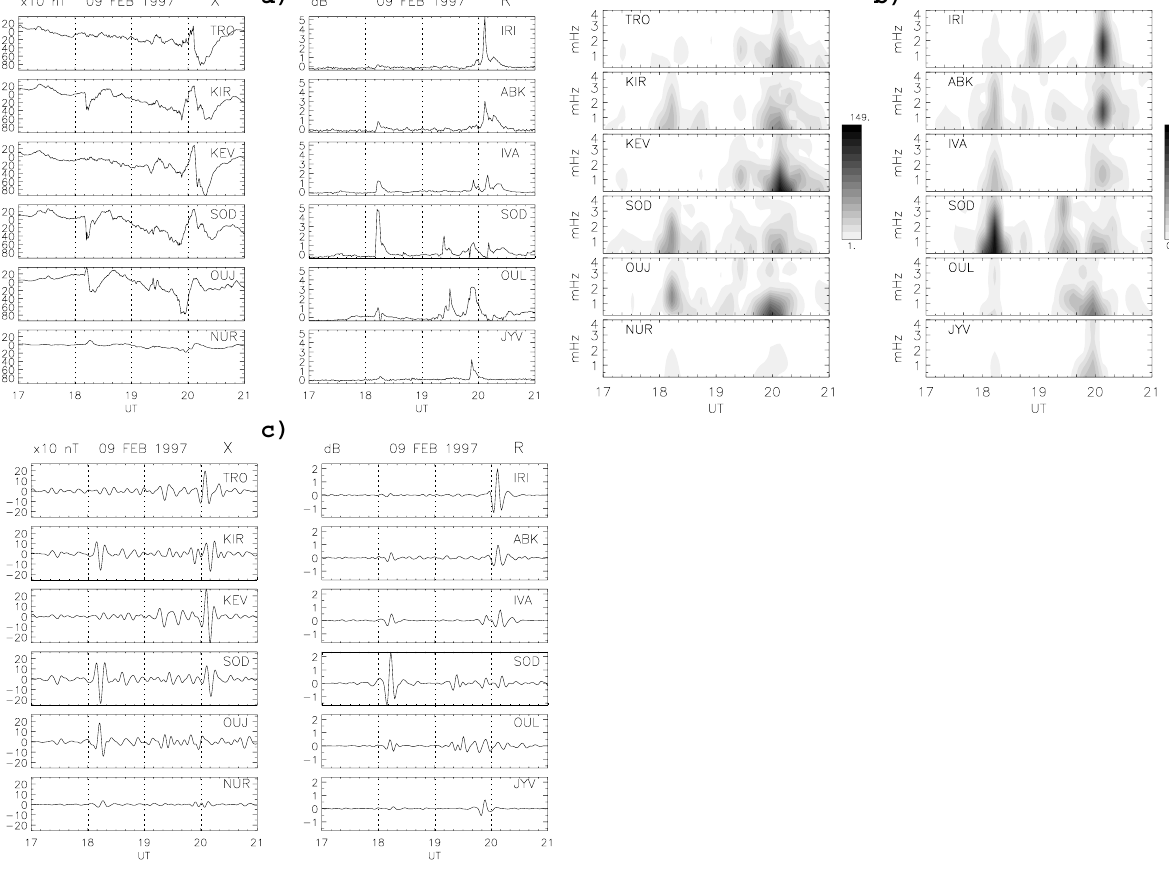
The plot shows a sharp border at the CGM latitude of 65 ◦ , equatorward of where the activity attenuates